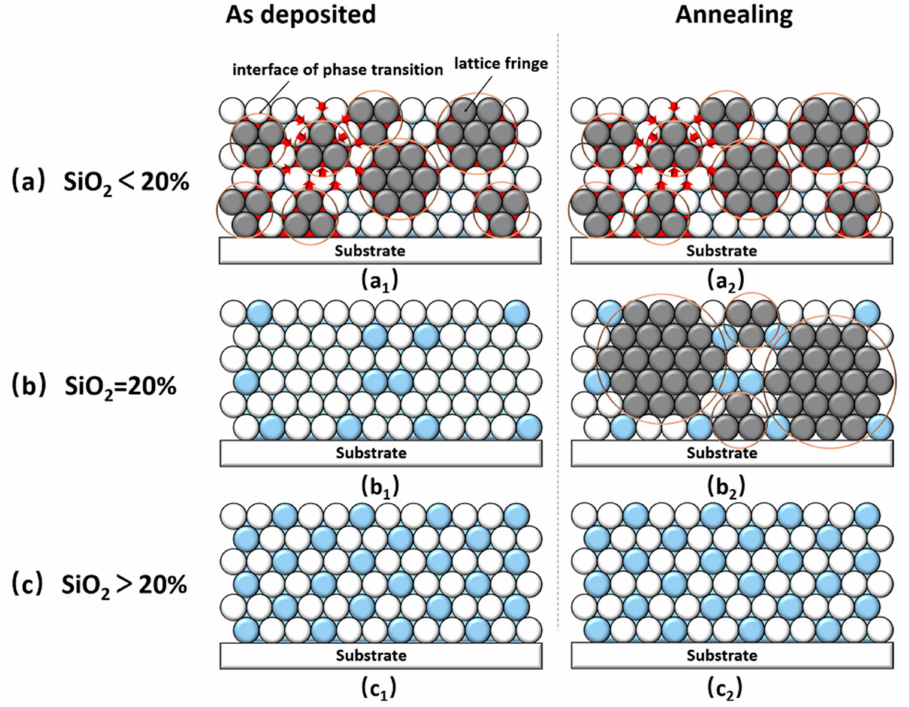
Figure 6. The phenomenological model describing the evolution of the crystalline states and microstructure of the nanocomposites during gradual annealing post-processing. As-deposited Hf 1 − x Si x O 2 nanocomposites: x < 20% ( a 1 ), x = 20% ( b 1 ) and x > 20% ( c 1 ); Hf 1 − x Si x O 2 nanocompos- ites after annealing: x < 20% ( a 2 ), x = 20% ( b 2 ) and x > 20% ( c 2